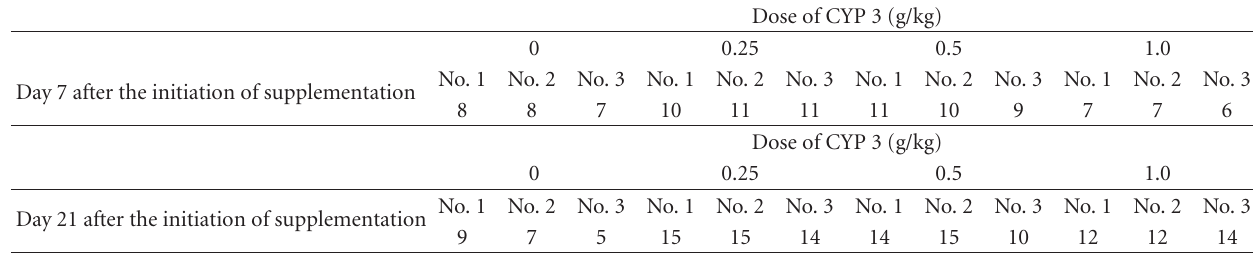
Table 10: E ff ects of Chinese Yam polysaccharide (CYP) 3 on the complexity of the intestinal bacterial population from cecal digesta in weaned rats ( n = 3). The data indicate the numbers of bands in DGGE lanes,which reflects the complexity of the bacterial population in the di ff erent treatment groups, as also indicated in Figures 3(a) or 4(a) and 3(b) or 4(b), respectively.